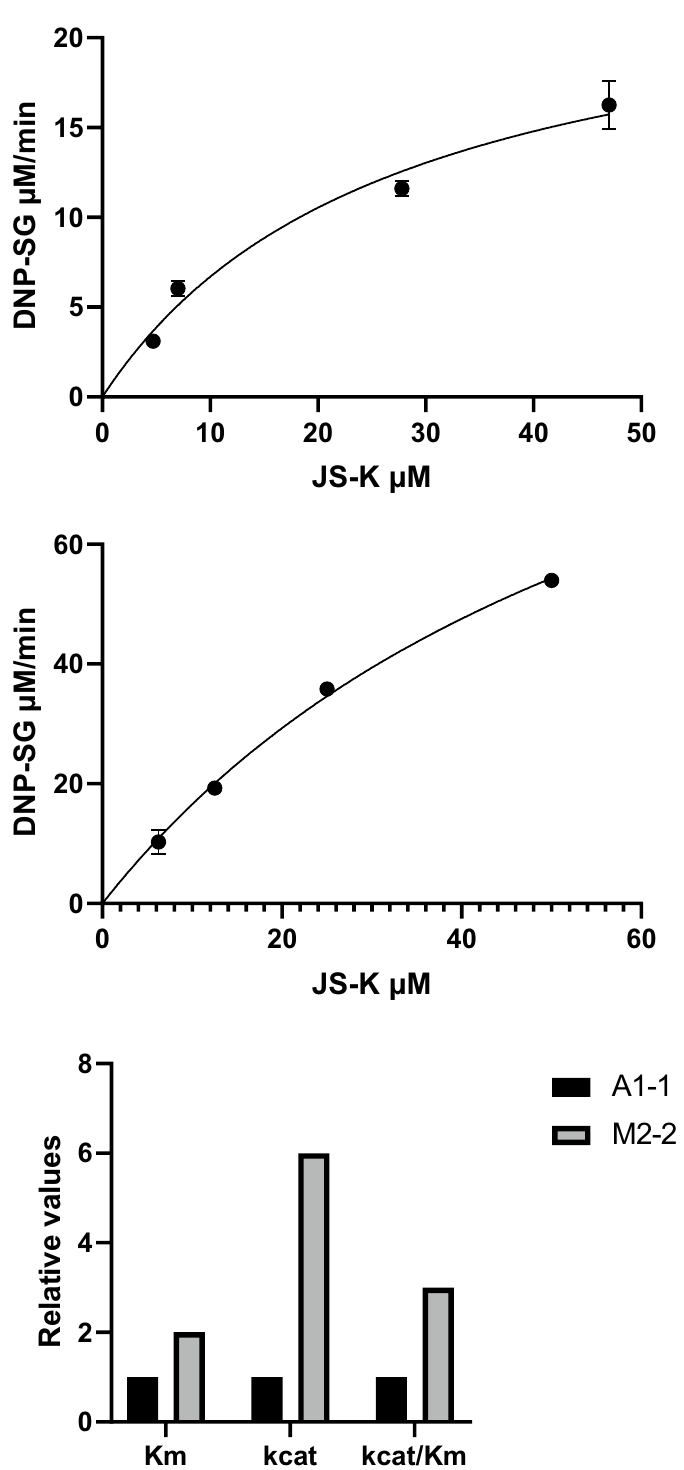
Figure 3. ( a ) Substrate saturation curve of human GST A1-1 with JS-K. ( b ) Substrate saturation curve of human GST M2-2 with JS-K. The assay was performed spectrophotometrically at 30 °C and pH 7.5 with 1 mM GSH and varied JS-K concentrations. Data points are represented as means and standard deviation of triplicate measurements. The Michaelis–Menten equation was fitted to the experimental data by nonlinear regression using Graphpad Prism 8 software. ( c ) Comparison of steady-state kinetic parameters in the conjugation JS-K by human GST A1-1 and GST M2-2. Relative values are shown normalized against the parameters of GST A1-1. Original values were: GSTA 1–1: Km 27 ± 6.2 µM, kcat 55 ± 6.2 s −1 , kcat/Km 2 × 10 6 M −1 s −1 ; GST M2-2: